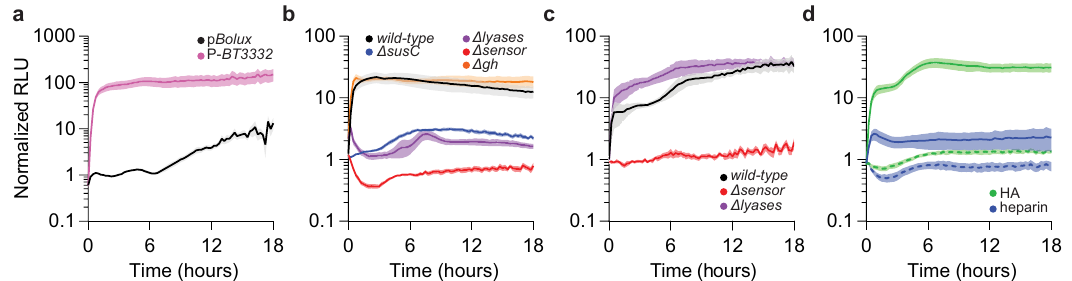
Fig. 3 | Construction of a glycan-responsive reporter in Bt. a Relative lumines- cencefrom wild-typeBt strainsharboring p Bolux (black)oraplasmid includingthe promoter region preceding the CS-inducible susC gene (P- BT3332 , pink) following the introduction of CS as the sole carbon source normalized by the relative lumi- nescence of identical cultures supplied galactose. Values are the mean of 12 bio- logical replicates and error is SEM in color-matched shading. b Relative luminescence from wild-type Bt (black) or strains lacking a CS-inducible susC ( Δ BT3332 , blue), 3 CS-speci fi c lyases ( Δ BT3324 Δ BT3350 Ω BT4410 , purple), CS- sensor ( Δ BT3334 , red), or a glucuronyl hydrolase ( Δ BT3348 , orange) harboring P- BT3332 following the introduction of an equal mixture of CS and galactose nor- malized to measurements from identical strains supplied galactose alone. c Relative luminescence from wild-type Bt (black) or strains lacking 3 CS-speci fi c